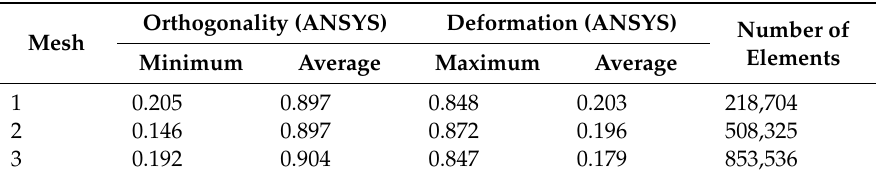
Table 2. Quality parameters of the constructed meshes.